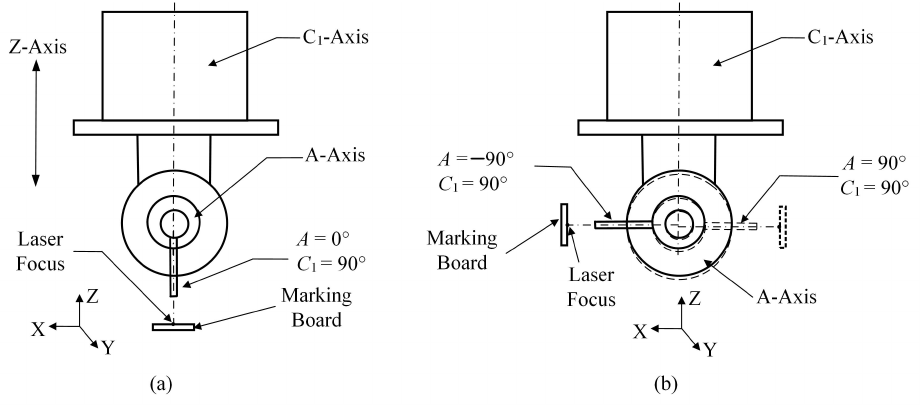
Figure 5. The measurement process of linkage parameters. ( a ) The measurement process of R A . ( b ) The measurement process of L tA